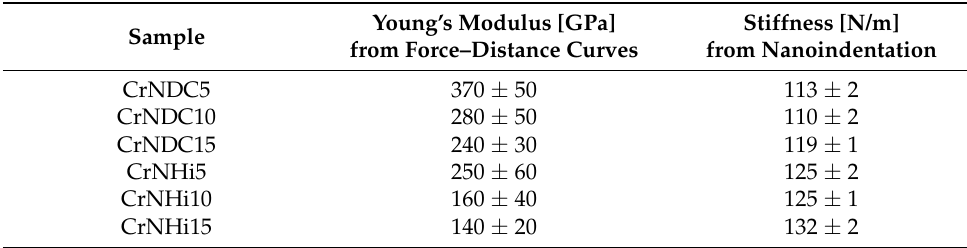
Table 5. Young’s Modulus and material